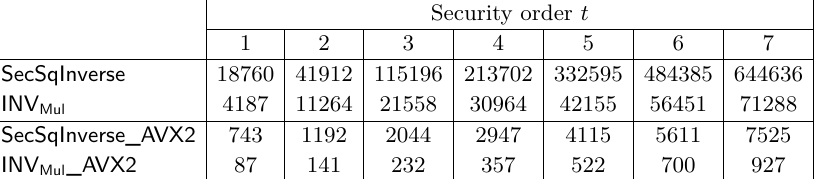
Table 3: Comparison for the inversion in S/q between multiplicative masking and our technique for a naive and an optimized implementation of the polynomial multiplication, in thousands of cycles.